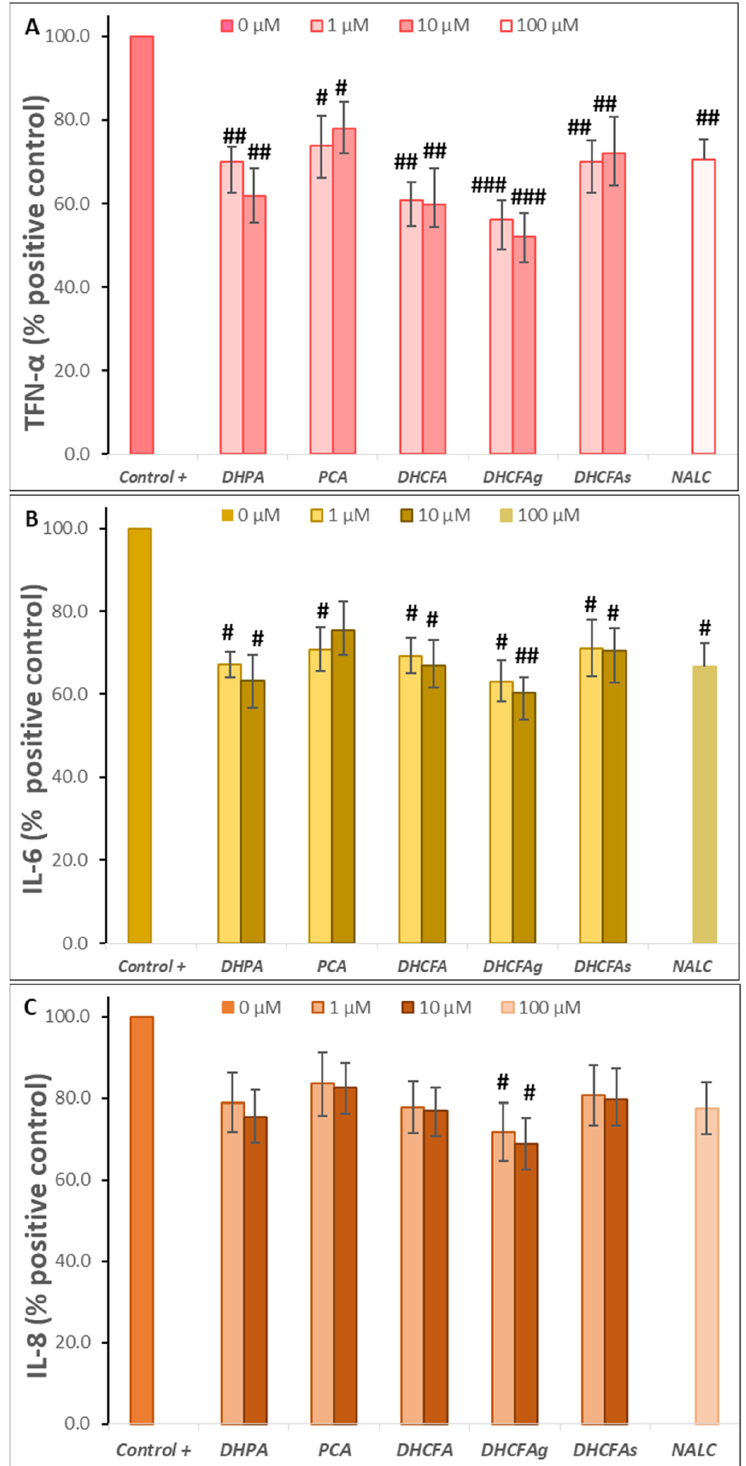
Figure 7. Effects of microbial-derived phenolic acids (DHPA, PCA, and DHCFA) and conjugated derivatives (DHCFAg and DHCFAs) (1 and 10 μ M) on the production of proinflammatory makers in RAW 264.7 macrophages under LPS (100 ng/mL) inflammation damage for 24 h of co-incubation: ( A ) TNF- α , ( B ) IL-6, and ( C ) IL-8. # , ## , ### Significant differences ( p < 0.05, p < 0.01, p < 0.01, respectively) relative to the positive control (+).